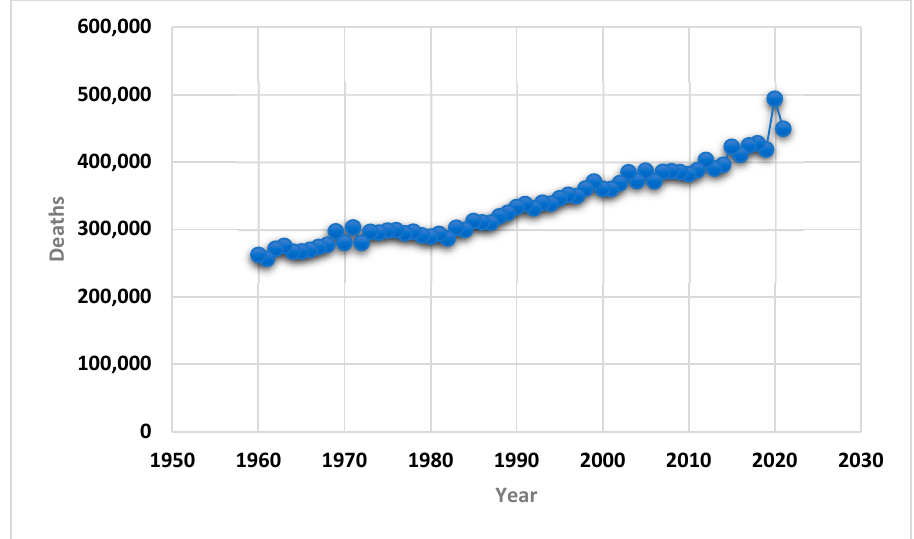
Figure 1. Evolution of the number of deaths in Spain from 1960 to 2021. Source: Expansión and the authors’ creation.